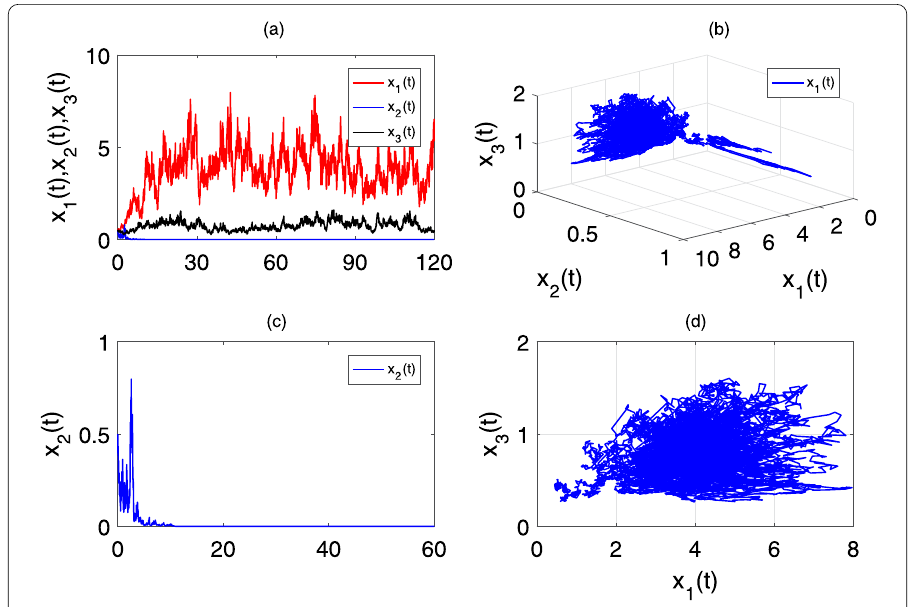
Figure 4 Extinction of the prey population x 2 ( t ) of system (2). (a) Time sequence diagram and (b) the phase portrait of system (2).( x 1 (0), x 2 (0), x 3 (0)) = (0.5,0.5,0.5), σ 2 1 ( t ) = σ 2 3 ( t ) = 0.1 + 0.04sin t , σ 2 2 ( t ) = 2.5 + 0.04sin